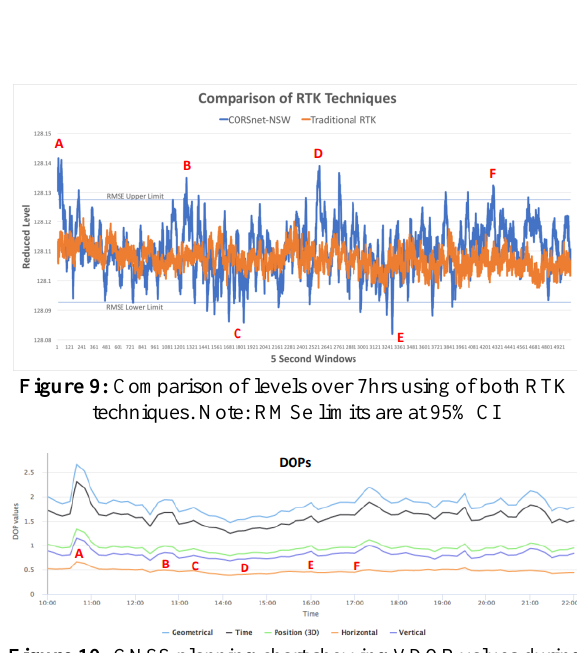
Figure 10: GNSS planning chart showing VDOP values during data